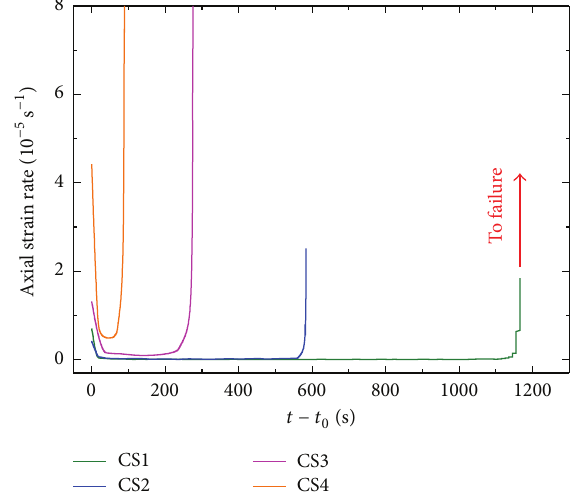
Figure 7: Axial strain rate versus time curves of the four concrete specimens at the creep